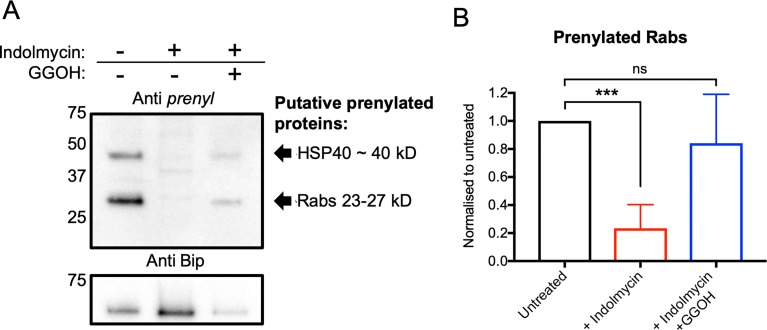
Apicoplast inhibitors decrease global parasite prenylation in the second IDC after treatment.(A) Immunoblot analysis of parasites treated with indolmycin (50 μM) with or without polyprenol rescue (5 μM GGOH), as indicated. Parasite lysates were collected after saponin isolation during their second IDC, and immunoblots were probed using anti-farnesyl (1:2,000) to analyse global parasite prenylation. Prenylated species are annotated as putative Rabs (23–27 kD) or HSP40 (40 kD) (assignment based on published P. falciparum prenylomes) [27,28]. Anti-Bip (1:1,000) were used as a loading control with an expected size of 65 kD. Immunoblot is representative of four independent experiments. (B) Quantification of the 27 kD Prenylated Rabs, normalised to average density of untreated. Data are presented as the means of four independent experiments ± SD. ***P < 0.001, two-tailed Student t test. See S2 Data for numerical data underlying figure. GGOH, geranylgeraniol; IDC, intraerythrocytic developmental cycle; ns, not significant.